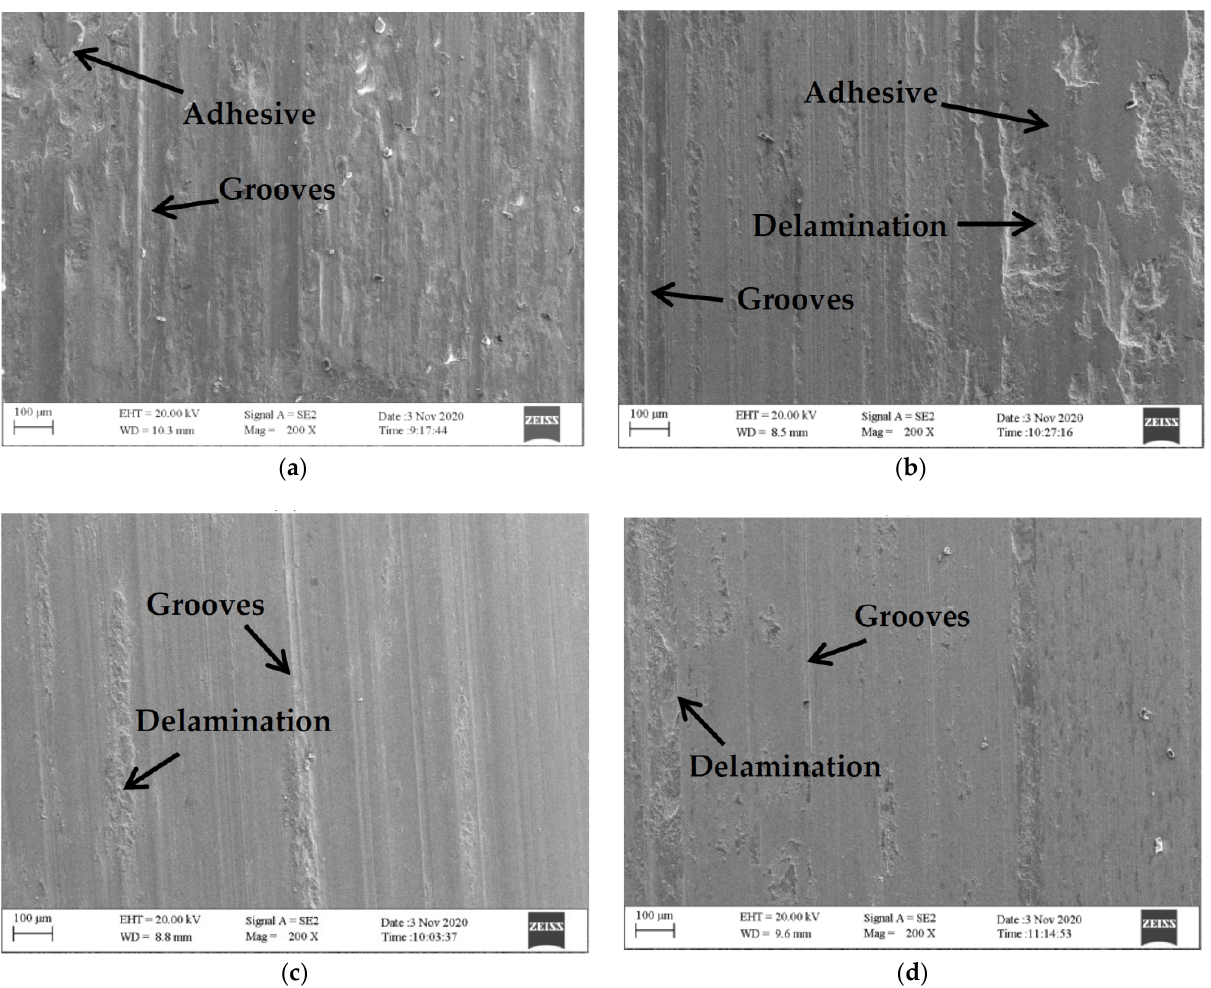
Figure 6. Wear morphology of AlCoCrFeNi(WC) x : ( a ) AlCoCrFeNi(WC) 0 ; ( b ) AlCoCrFeNi(WC) 0.1 ; ( c ) AlCoCrFeNi(WC) 0.2 ; and ( d ) AlCoCrFeNi(WC) 0.3 .